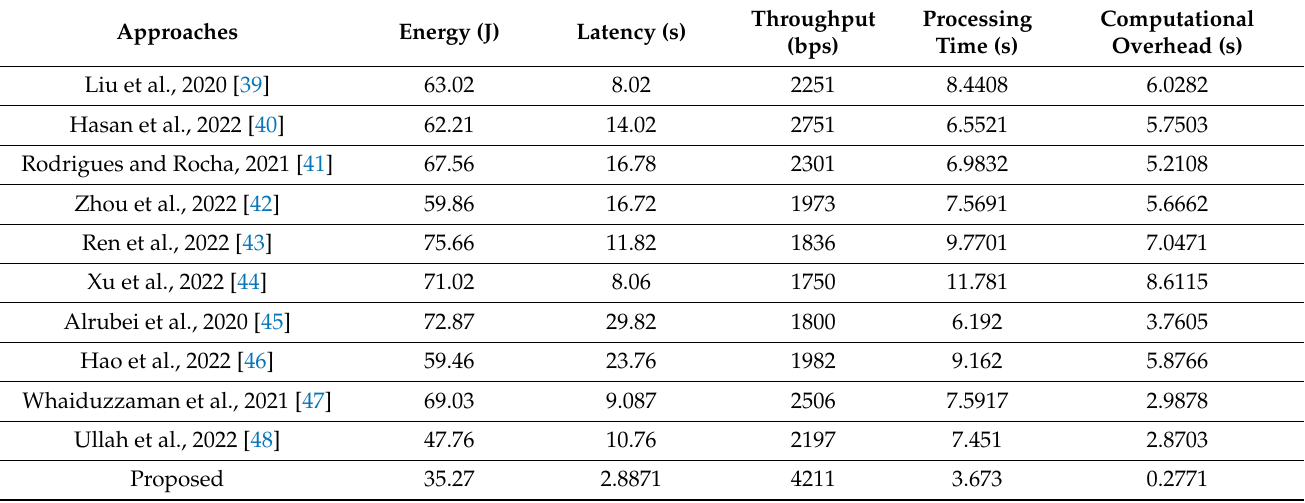
Table 2. Numerical outcomes of comparative